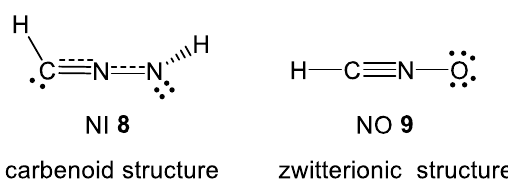
Chart 1. Electron Localisation Function (ELF)-based carbenoid and zwitterionic Lewis-like structures of the simplest NI 8 and NO 9 Three-Atom-Components